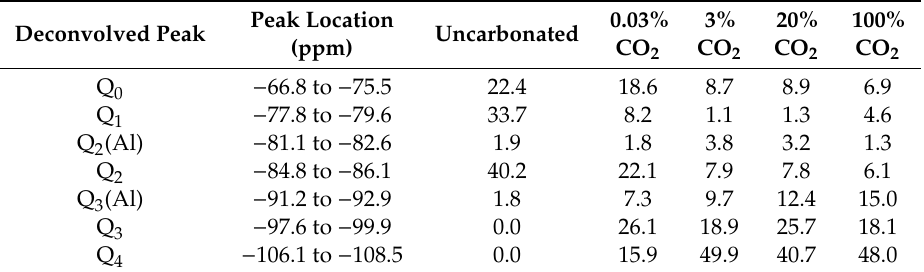
Figure 4. NMR spectra of slag blended cement pastes with and without carbonation: ( a ) uncarbonated; ( b ) 0.03% CO 2 ; ( c ) 3% CO 2 ; ( d ) 20% CO 2 ; ( e ) 100% CO 2 . The corresponding chemical shifts and relative intensities were deconvoluted by the Gaussian function and are presented in Table 3. Table 3. Deconvolution results of NMR spectra.